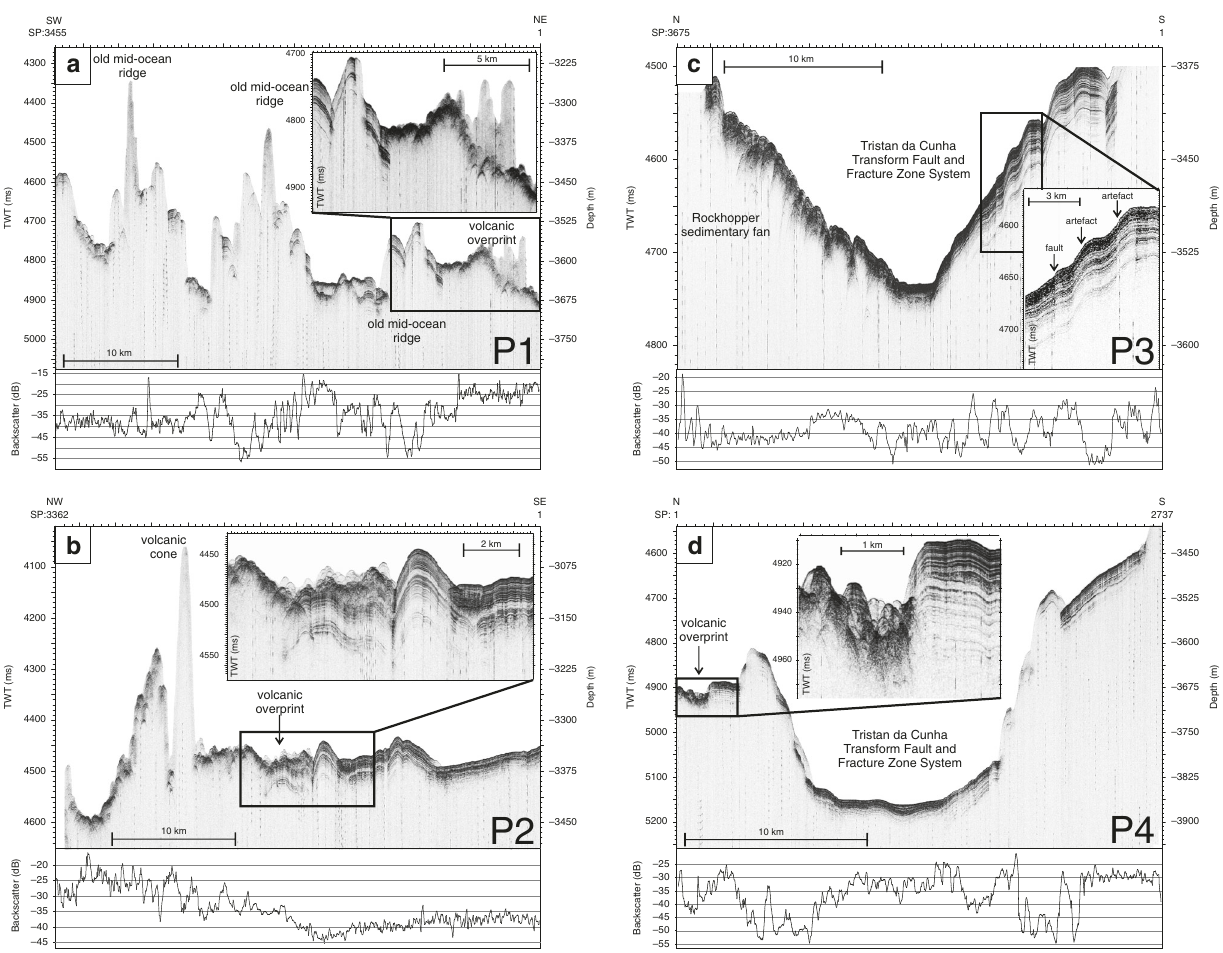
Fig. 9 Sub-bottom pro fi ler sections. Sub-bottom pro fi ler (Parasound) pro fi les (see Fig. 5b for location). Seabed backscatter intensities are plotted below each pro fi le. a Pro fi le P1 across the oceanic sea fl oor to the west of Tristan da Cunha. b Pro fi le P2 across the southeastern border of volcanic fi eld A. c Pro fi le P3 across the Tristan da Cunha Transform Fault And Fracture Zone System and the southern part of the submarine fan southwest of Nightingale Island. d Pro fi le P4 across the Tristan da Cunha Transform Fault And Fracture Zone System southeast of Tristan da Cunha. Most of the apparent steep-to- vertical offsets in the sub-bottom pro fi ler data are artefacts caused by trace